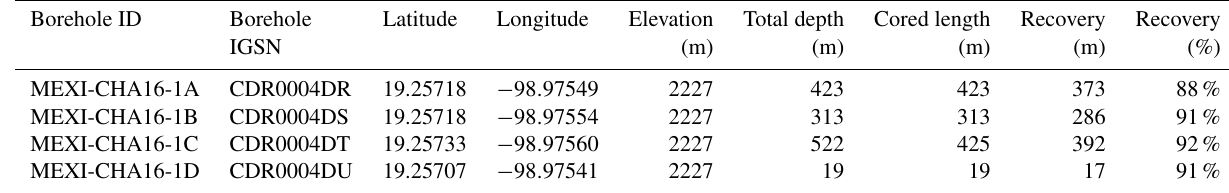
Table 1. Summary data for drilling sites and cores.